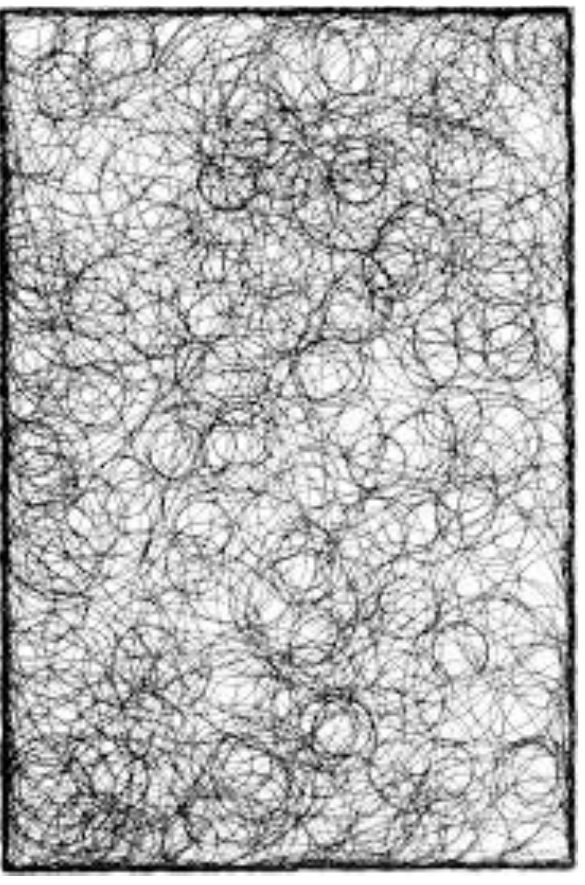
Figure 1 | Georg Nees, Gewölle. Experiment in texture. 1965.